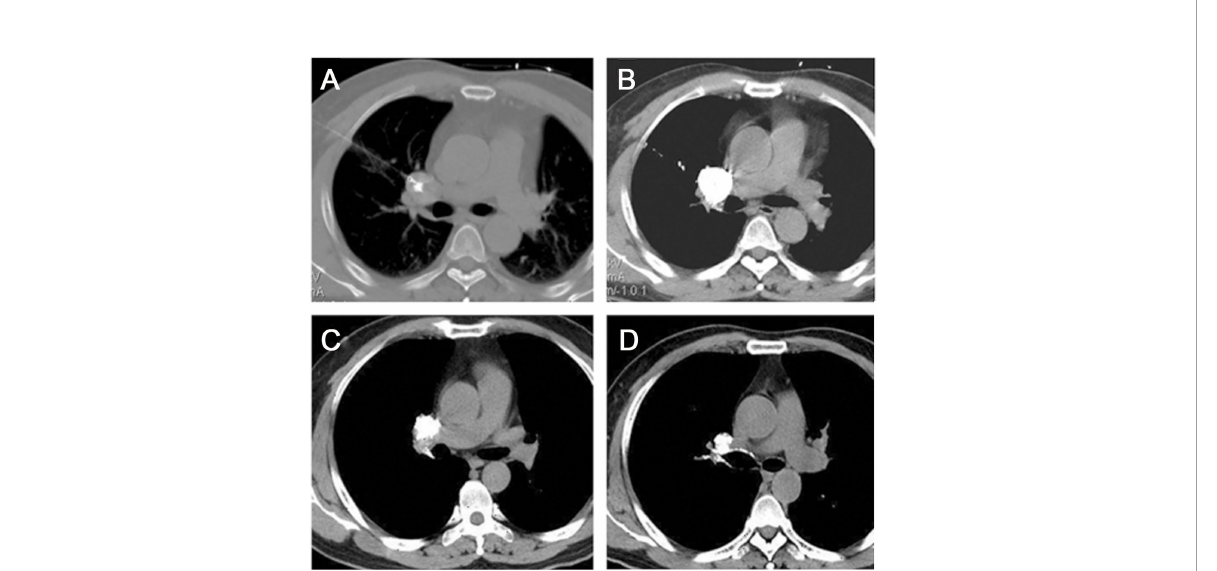
FIGURE 2 Chemical ablation of a lymphatic node metastasis in the right pulmonary hilar region. (A) Transverse CT before chemical ablation showed a tumor at the lung hilum. The needle tip was located in the center of the target LN. (B) The image obtained after a single injection of the ethanol-ethiodol-drugs mixture showed good LN permeation. (C-D) At 6 and 12 months after ablation, the tumor size gradually decreased. (Liu SR et al., Technol Cancer Res Treat,